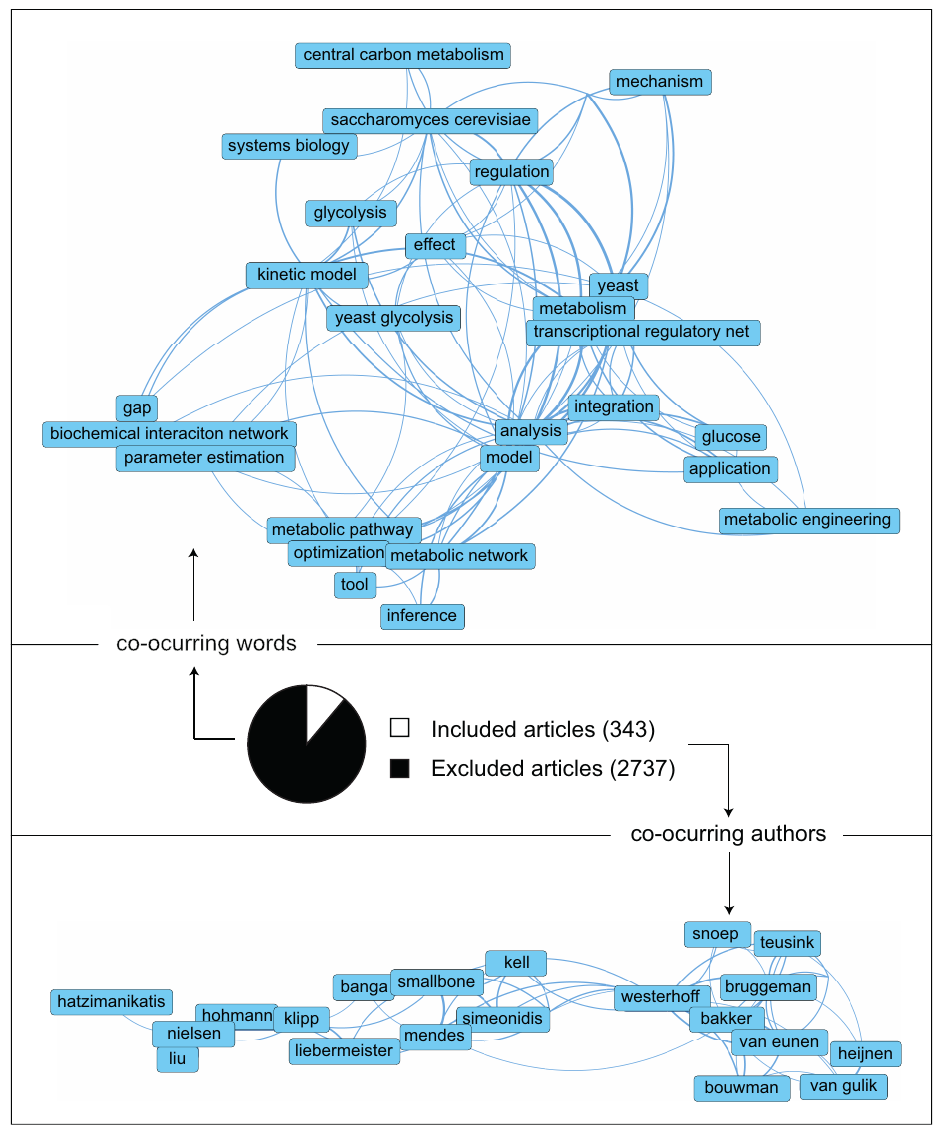
Figure 1. The literature collection presents the scientific landscape: (center) Articles examined in the reviewing process and fraction selected for this study. (top, bottom) Visualization of most co- occurring words and authors, respectively. in the titles of the selected articles. Obtained in VOSviewer. For the word map: counting method = binary, minimal occurrences = 5, terms selected = 100%. For the author map: counting method = full. The remaining setup was the